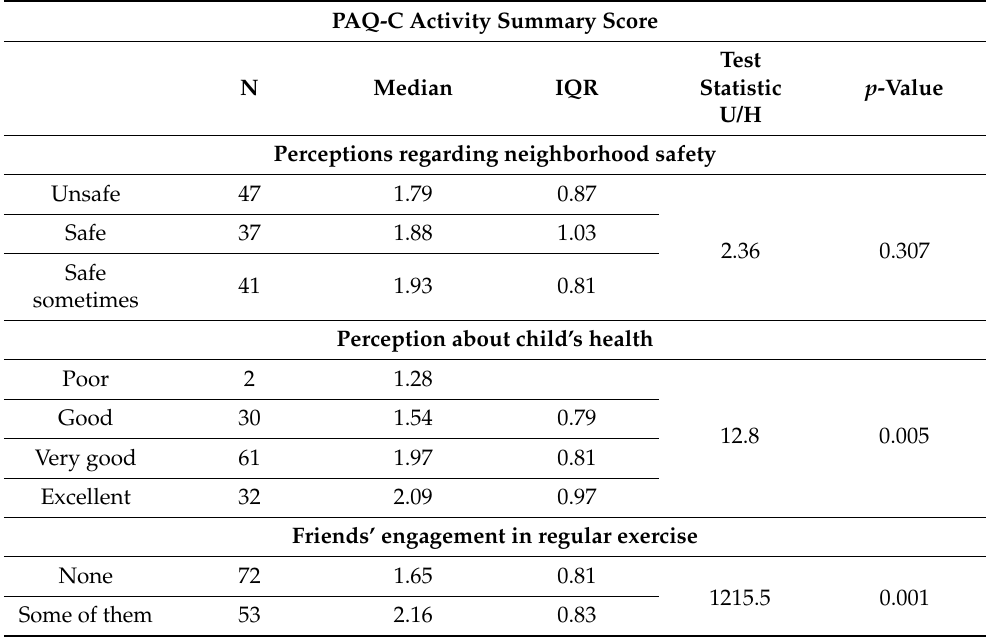
Table 5. Comparison of physical activity questionnaire summary score across categories of parent’s